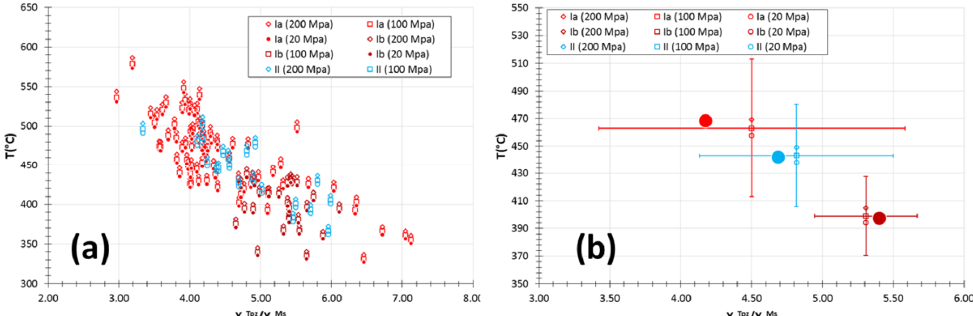
Figure 14. ( a ) Temperature estimates based on the F-OH exchange thermometer, assuming an ideal mixing model between muscovite and topaz and 20 ≤ p ≤ 200 MPa [196]. ( b ) Mean (and standard error bars) and median temperature values for the Tpz Ia − Ms Ia , Tpz Ib − Ms Ib and Tpz II − Ms II pairs.